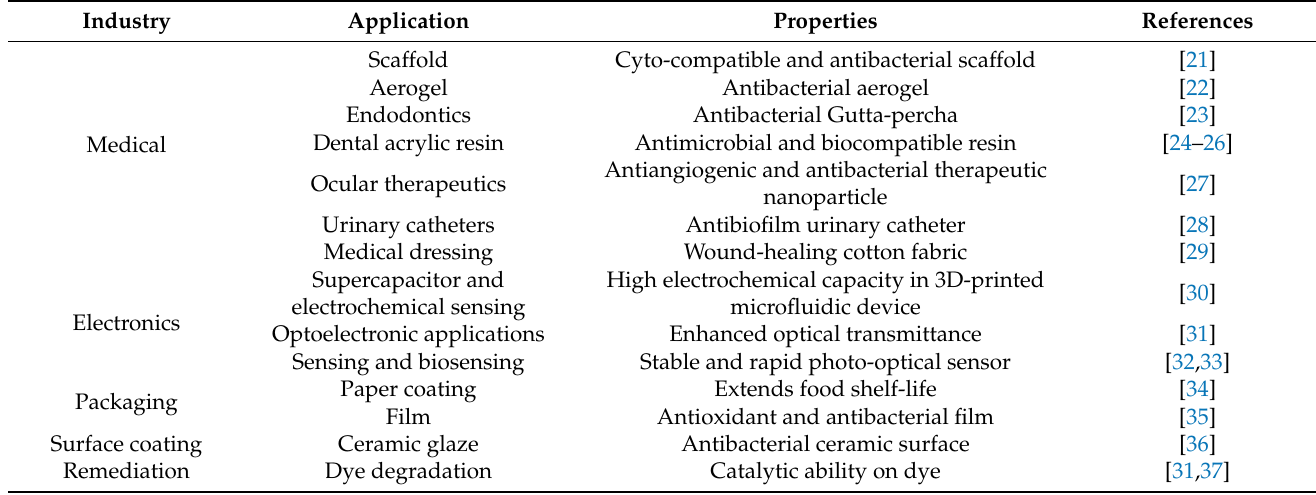
Table 1. Applications related to silver nanoparticles that have recently been investigated in multiple industries; a brief summary to illustrate the recent trends and advancements in the research of silver nanoparticle applications. Industry